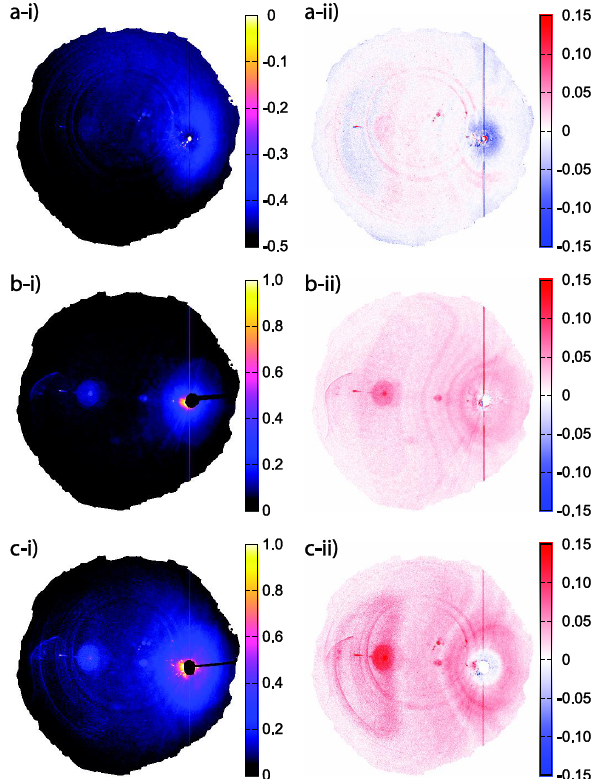
Figure 11. Stray light from the dome (top), lens and neutral density filter (middle), and whole system (bottom). The left column shows the fractional change in intensity due to stray light, while the right column shows the shift in the red-blue ratio from the shaded to unshaded image. Images were recorded against a clear (blue) sky, so stray light shifts toward the red. Note the scale change between (a) and (b , c) in the left column.